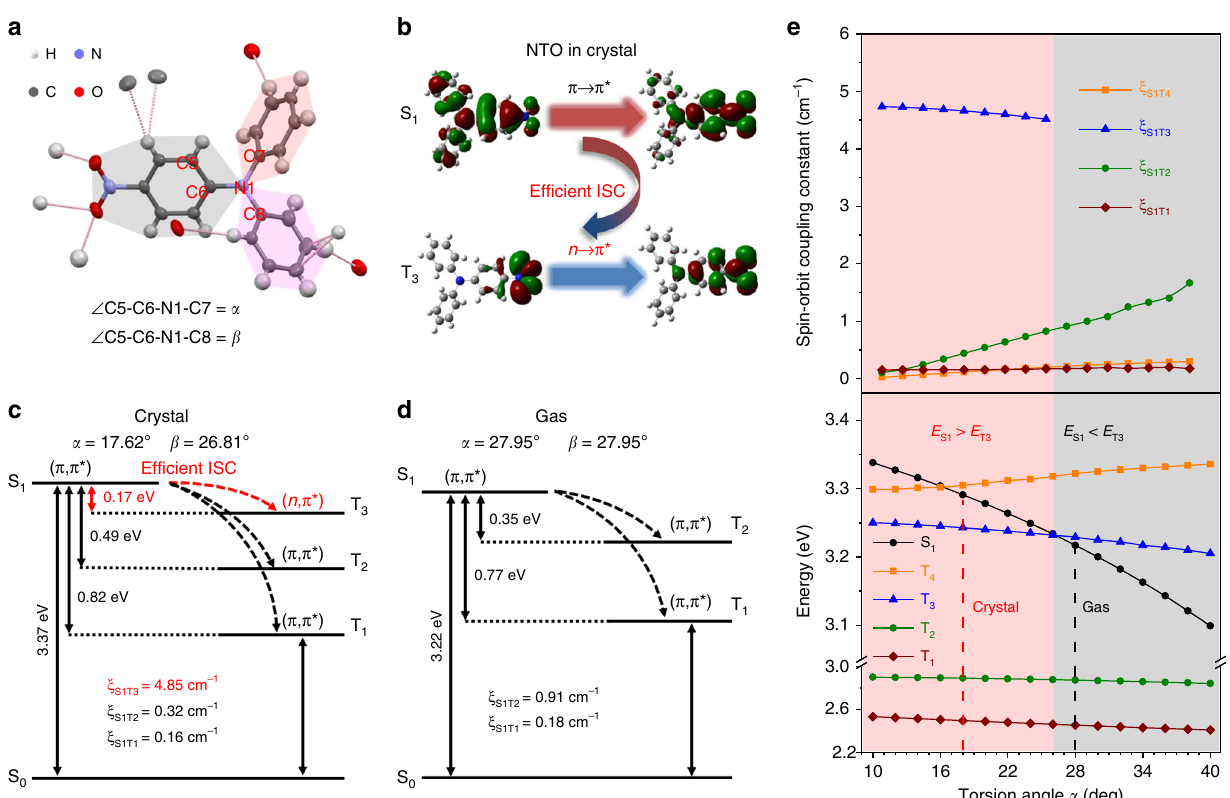
Fig. 3 Theoretical calculations on the emission mechanism of TPA-1N. a Crystal structure and intermolecular interactions between TPA-1N and its adjacent molecules. The torsion angle between nitrophenyl group and other two phenyl groups is assigned to α and β , respectively. b Nature transition orbitals of the lowest singlet excited state (S 1 ) and triplet excited state (T 3 ) of TPA-1N in crystal. c, d Calculated energy gaps, electronic con fi guration character and related spin – orbit coupling constants in crystalline and free gas states. e Potential energy curves of S 1 and T n and spin – orbit coupling constants ( ξ ) of related transitions from lowest S 0 to T n as a function of the torsion angle